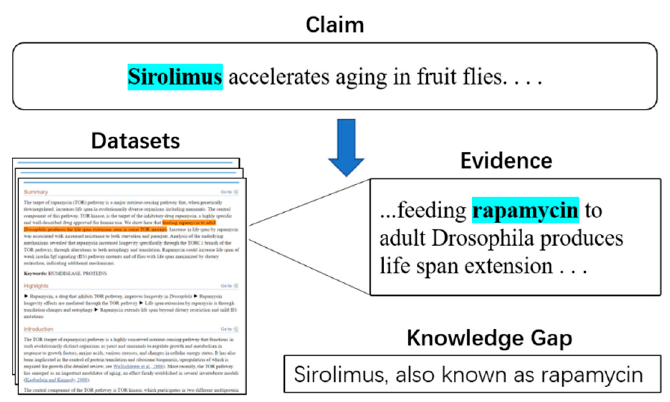
Figure 2. Knowledge gap hinders the reasoning process of FV systems.